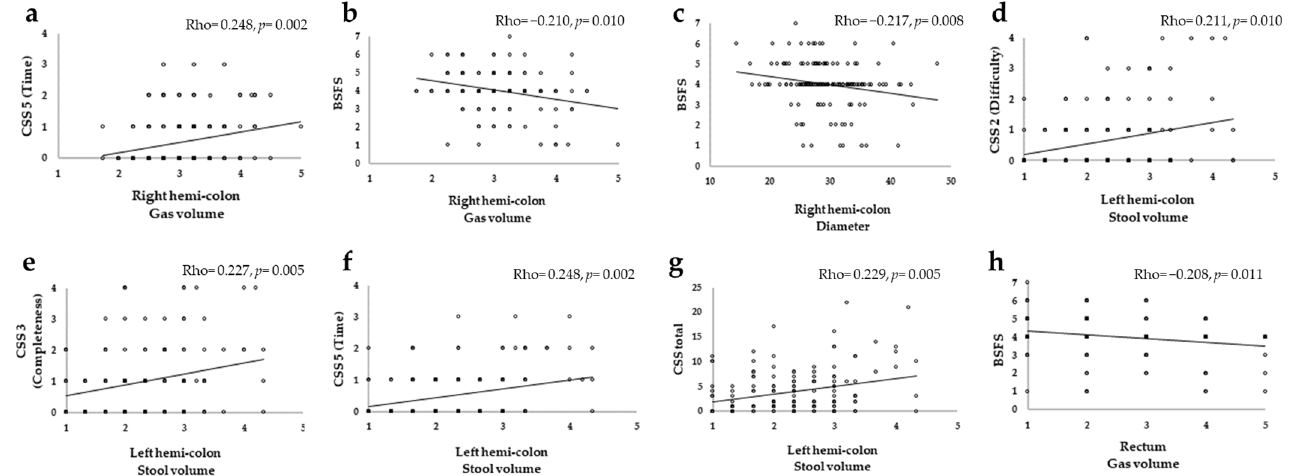
Figure 3. Scatter plot and the Spearman’s correlation coefficients of CT images and constipation symptoms. ( a ): Right hemi-colon gas volume and CSS5 (Time). ( b ): Right hemi-colon gas volume and BSFS. ( c ): Right hemi-colon diameter and BSFS. ( d ): Left hemi-colon stool volume and CSS2 (Difficulty). ( e ): Left hemi-colon stool volume and CSS3 (Completeness). ( f ): Left hemi-colon stool volume and CSS5 (Time). ( g ): Left hemi-colon stool volume and CSS total. ( h ): Rectum gas volume and BSFS. Correlation coefficient Rho ( p -value): Rho < − 0.20 or Rho > 0.20 with * p < 0.05 indicates a significant difference. CSS, Constipation Scoring System; BSFS, Bristol Stool Form Scale.